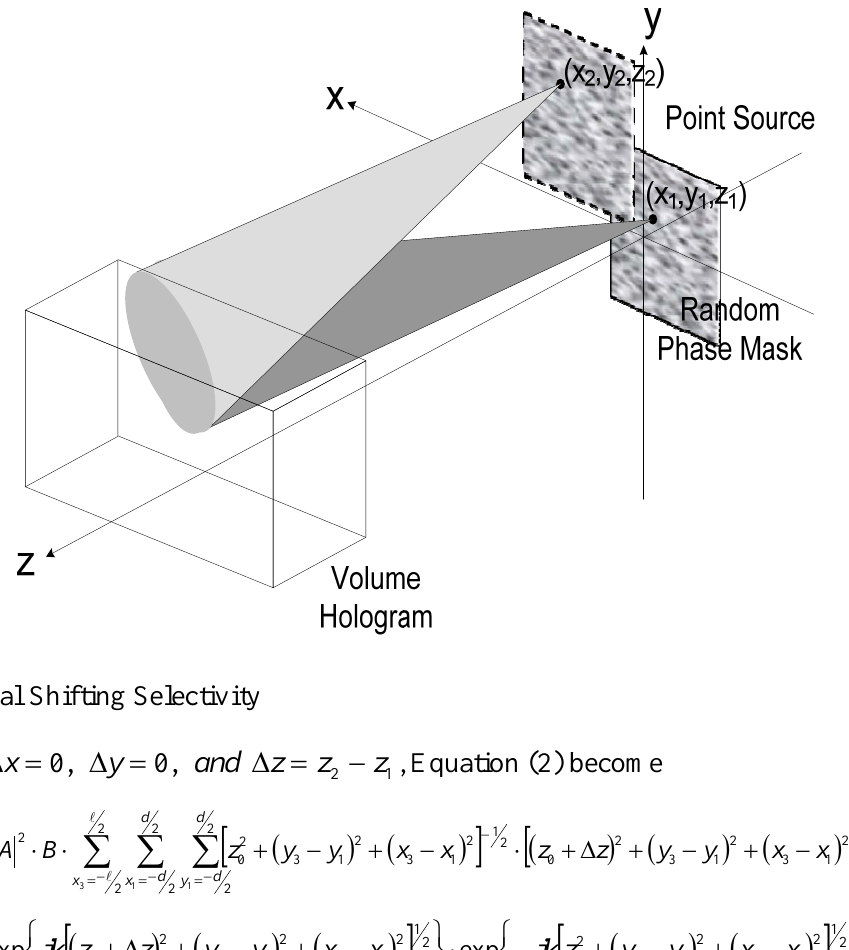
Figure 2. Schematic diagram of the shifting random phase encoding for volume